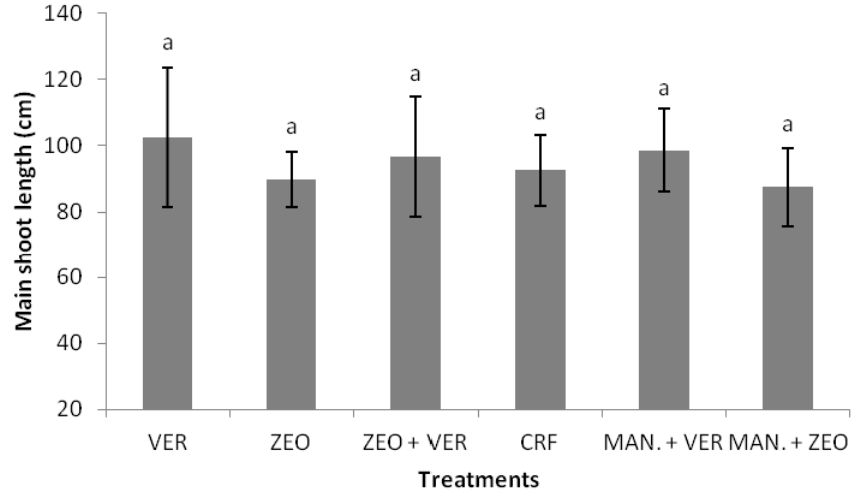
Figure 1. Main shoot length (cm) of the pepper plants among the treatments. The different letters on the bars signify statistically significant differences among the treatments, according to Duncan’s multiple range test, for p ≤ 0.05. VER: vermiculite; ZEO: zeolite; CRF: controlled-release fertilizer; MAN: manure.